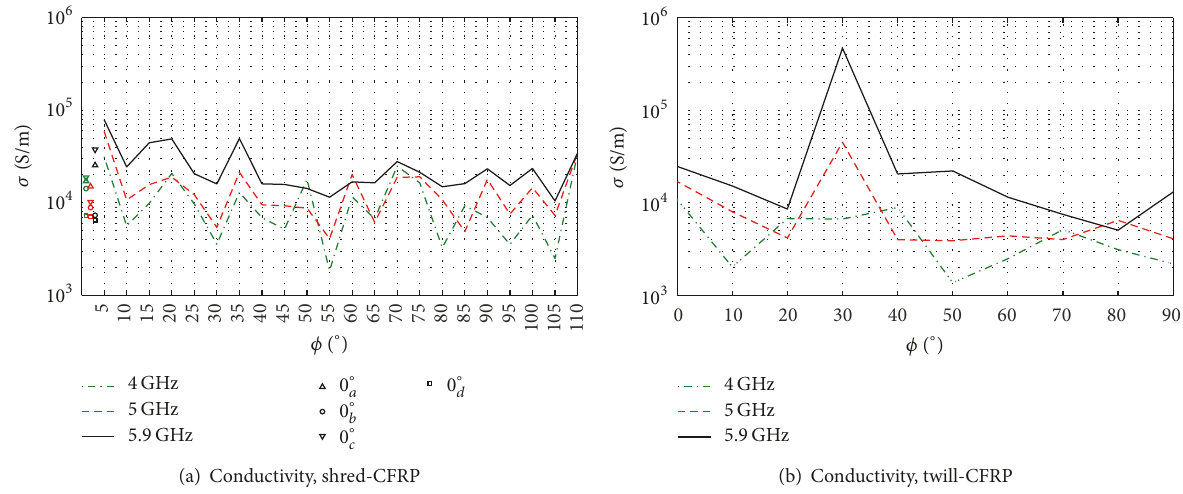
Figure 6: Conductivity of (a) shred-CFRP and (b) twill-CFRP dependent on the orientation of the cut sample.